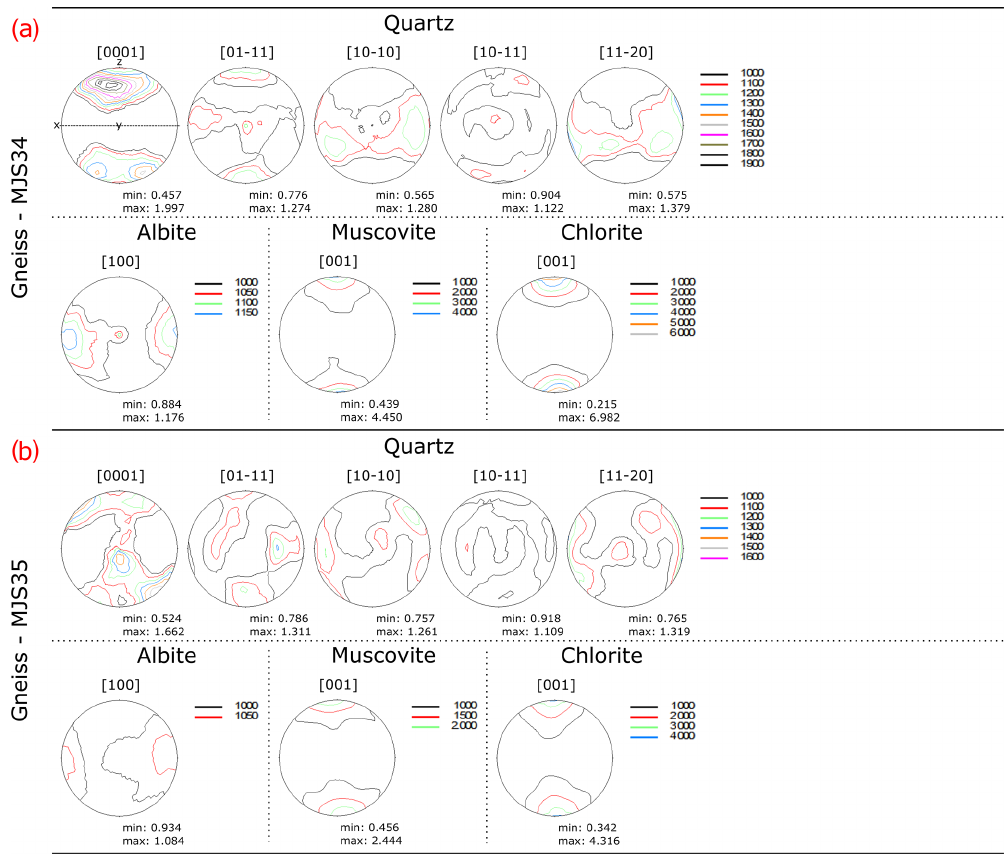
Figure 7. Calculated pole figures of important mineral phases in the gneisses ( a ; MJS34) and ( b ; MJS35). The stretching lineation (kinematic x direction) is oriented EW in the pole figures, the foliation normal (kinematic z direction) is oriented NS and the kinematic y direction (perpendicular to x and z directions) is normal to the pole figure plane. The pole figures are lower hemisphere equal area projections. The contour levels display multiples of random distribution and minimum and maximum values are listed below the pole